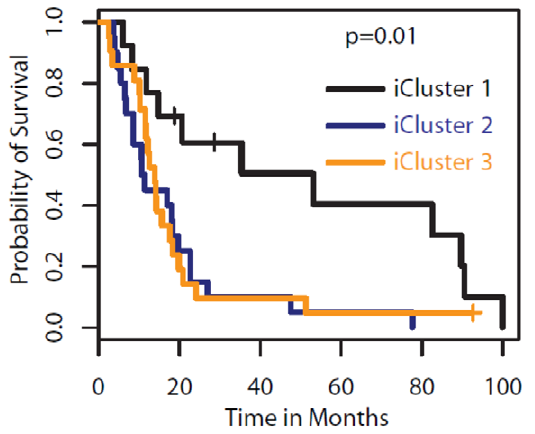
Figure 6. Kaplan-Meier plot. The three integrated subtypes of glioblastoma identified by iCluster show survival differences.